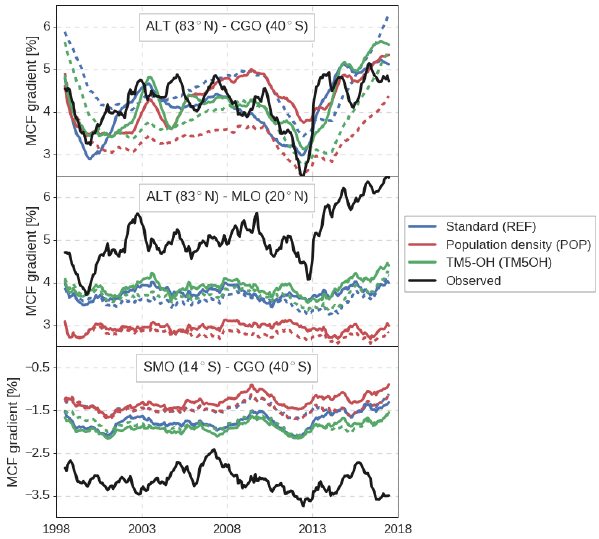
Figure 5. Time series of observed and modeled gradients between three sets of NOAA surface sites. Gradients are given relative to global mean MCF and averaged using a 12-month running mean. Dashed lines indicate prior mismatches, while solid lines show pos- terior mismatches. Site latitudes are also shown and further details on assimilated surface sites are given in Table